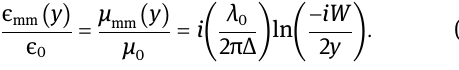
(C) second scenario (i.e., ii). Simulation results (both real and imaginary parts) are compared with the analytical solutions in the insets. GRIN,